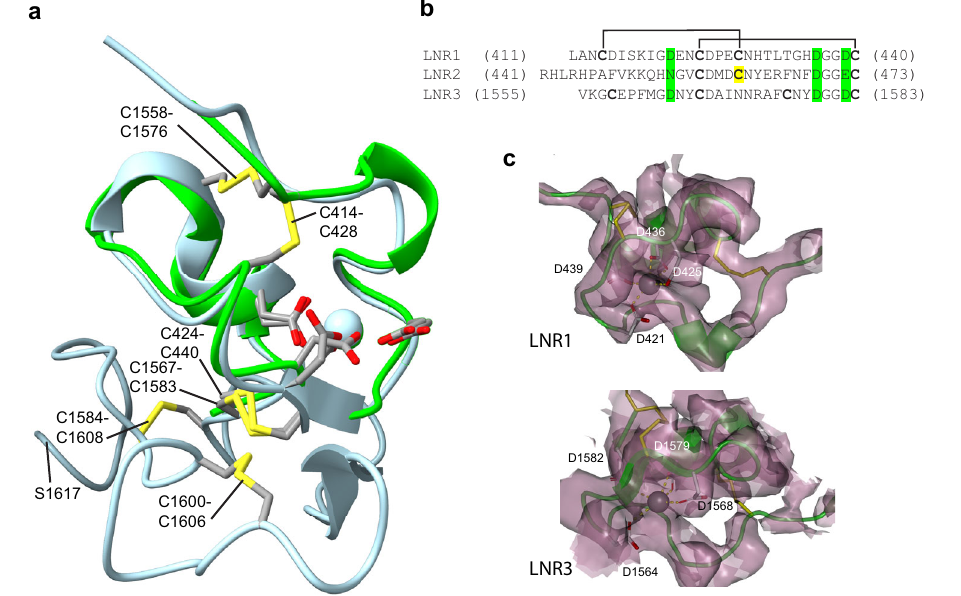
green).LNR1hastwodisul fi debonds.LNR2hasonedisul fi debondandanunpaired cysteine(C461,markedyellow).LNR3hastwodisul fi debondsarrangedinthe1-3/2- 4 pattern of LNR1, but two of the cysteine residues are not aligned. c Maps around the Ca 2+ ions of LNR1 and LNR3, respectively. The map (MAP1) was contoured at 4.0 σ